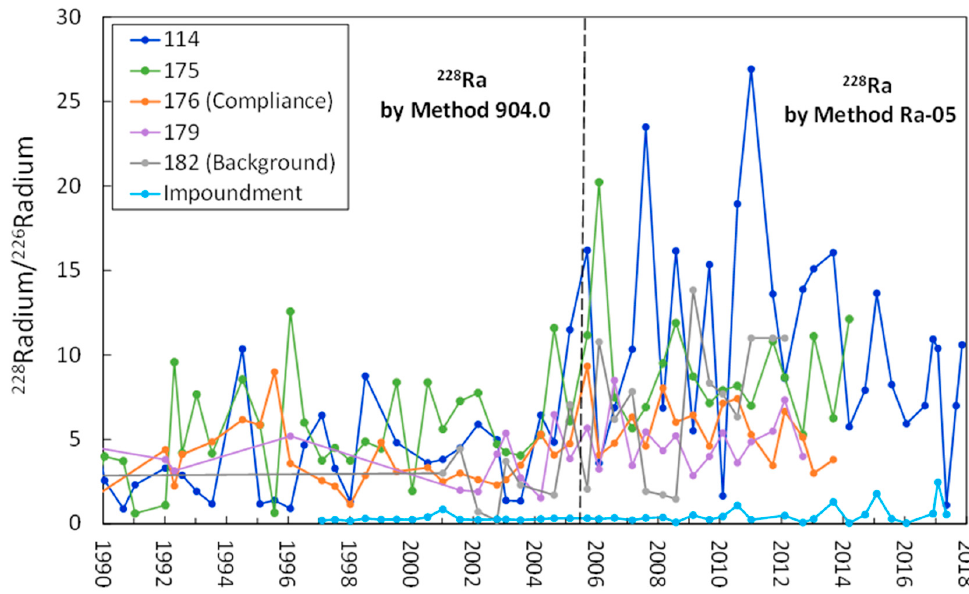
Figure 2. 228 Ra/ 226 Ra ratios in selected Site monitoring wells and the